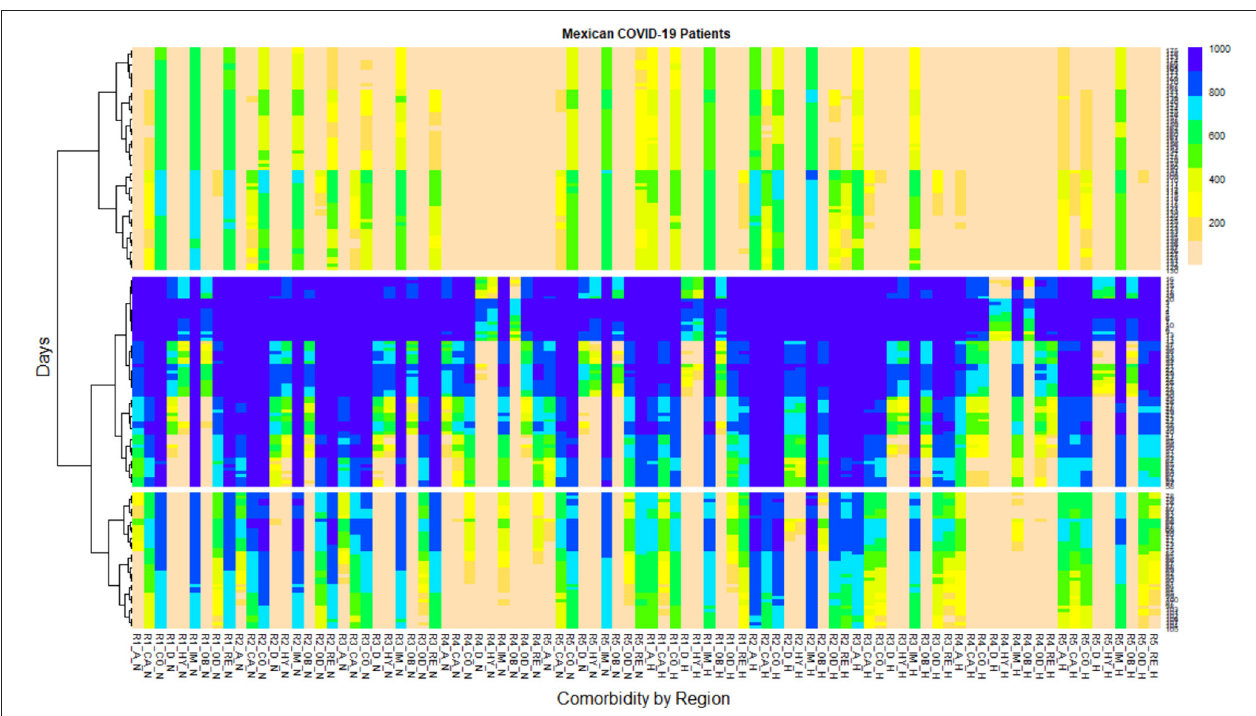
FIGURE 3 | SuperHeat map shows the daily behavior of the pandemic, grouping the lowest scale of infections to the highest density of infections by comorbidities in all regions of Mexico.